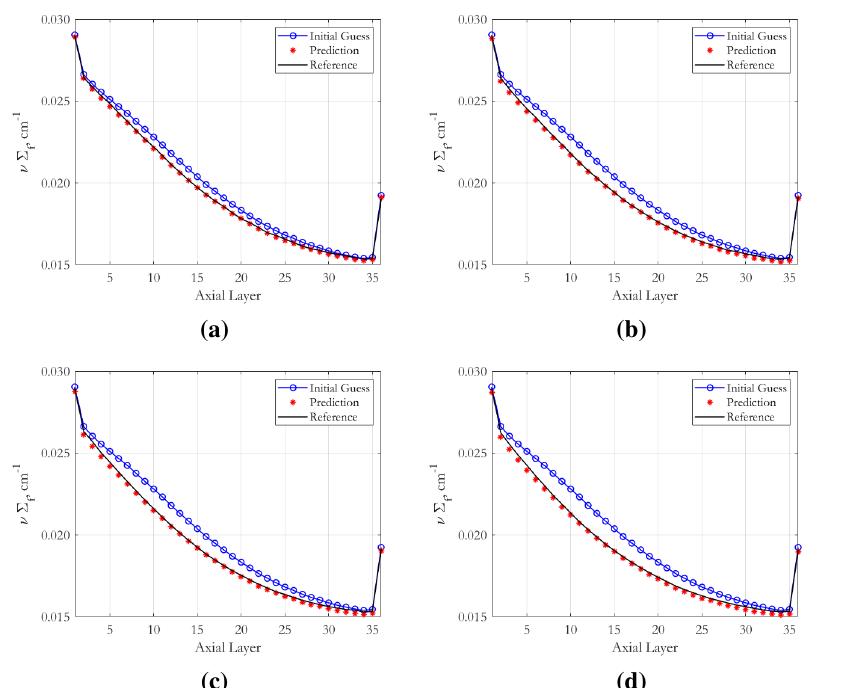
Figure 4: Predictions of the macroscopic fission neutron production’s spatial distribution (star markers) compared with the MC-generated reference solution (dashed lines) and the